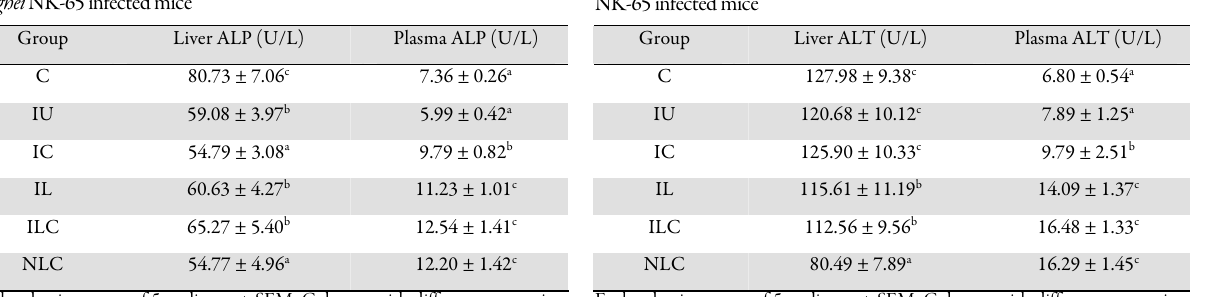
Table 5. The effect of lumefantrine and lumefantrine - copper complex on the specific activity of liver and plasma alanine aminotransferase of P. berghei